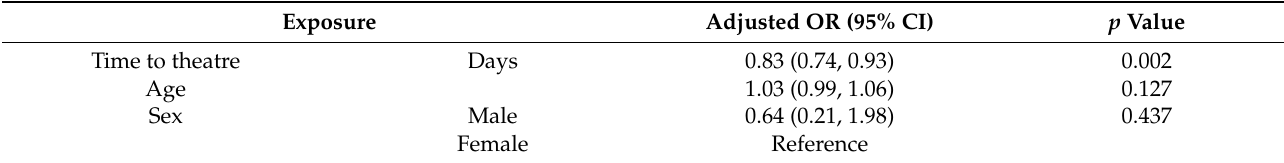
Table 3. Association between time to theatre and fracture